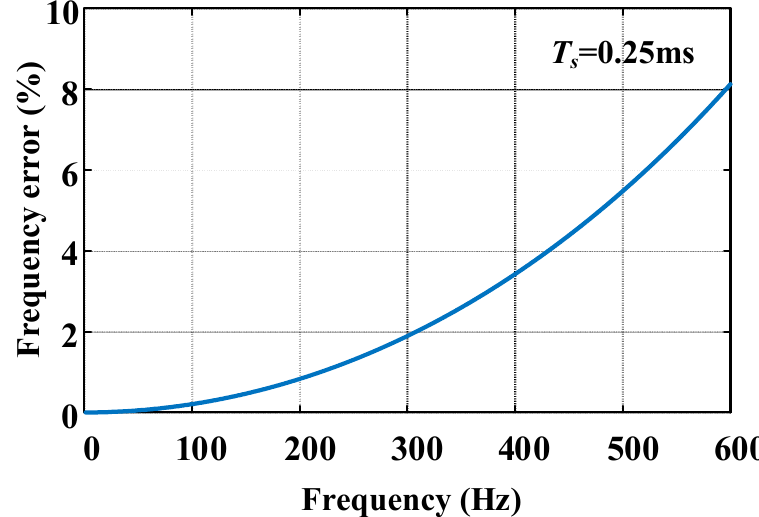
Figure 17. The frequency error of bilinear transformation. Redefine the mapping as